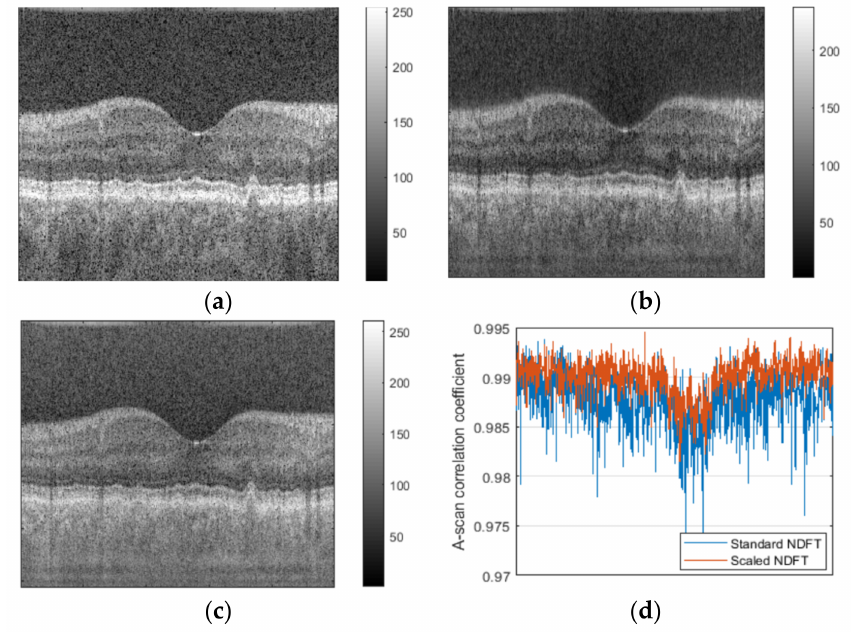
Figure 1. ( a ) Original OCT image of a human retina; ( b ) reconstructed image using standard NDFT (without scaling); ( c ) reconstructed image using our scaled NDFT; ( d ) correlation coefficients between corresponding A-scans of the original image and each reconstructed image.